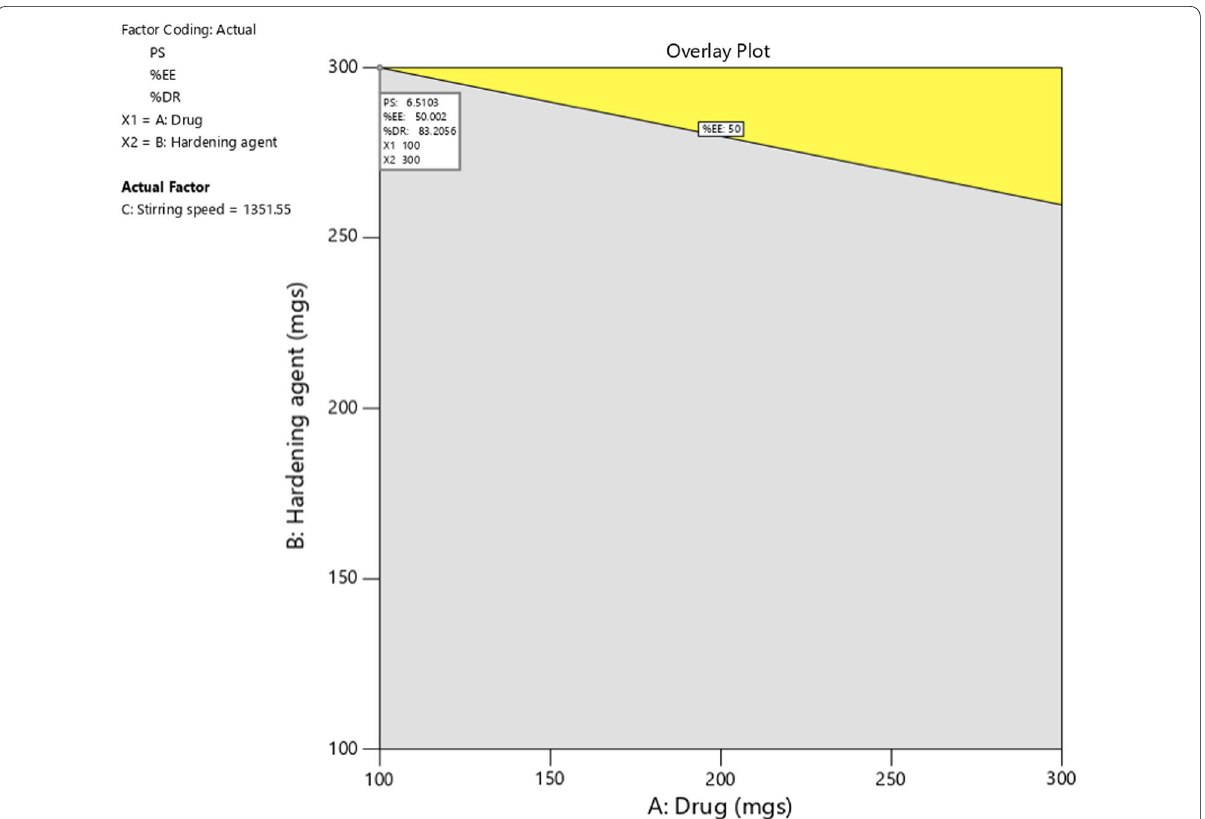
Fig. 4 Overlay plot for responses ( Y 1 – Y 3 ) of optimized formulation